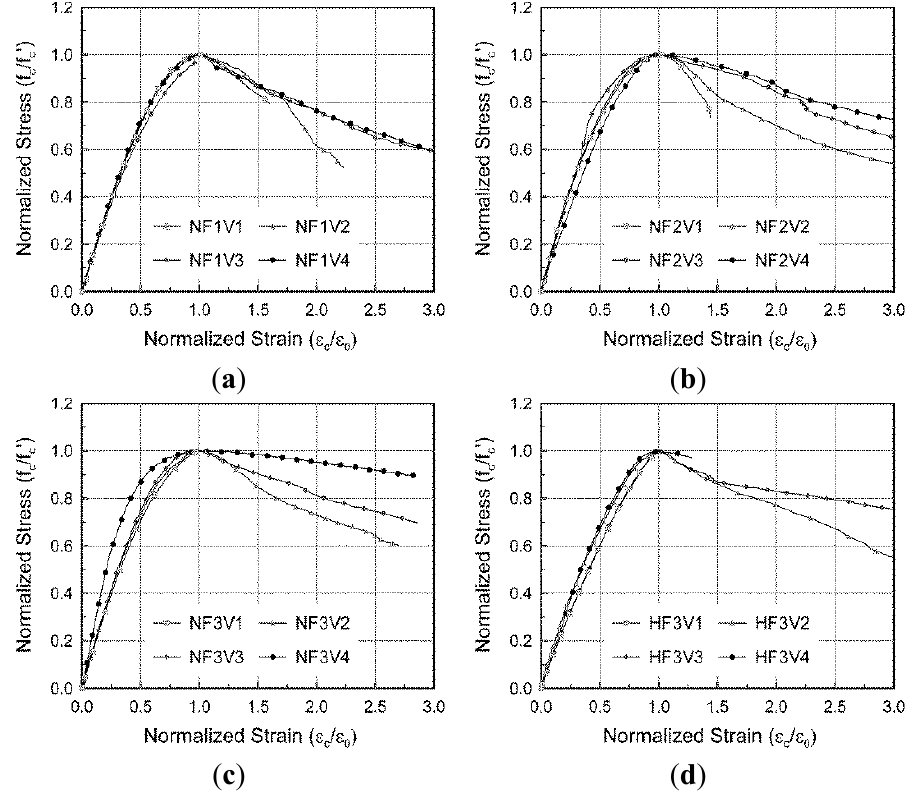
Figure 5. Effect of fiber volumetric ratio on the stress-strain response under compression. ( a ) NF1 series; ( b ) NF2 series; ( c ) NF3 series; ( d ) HF3